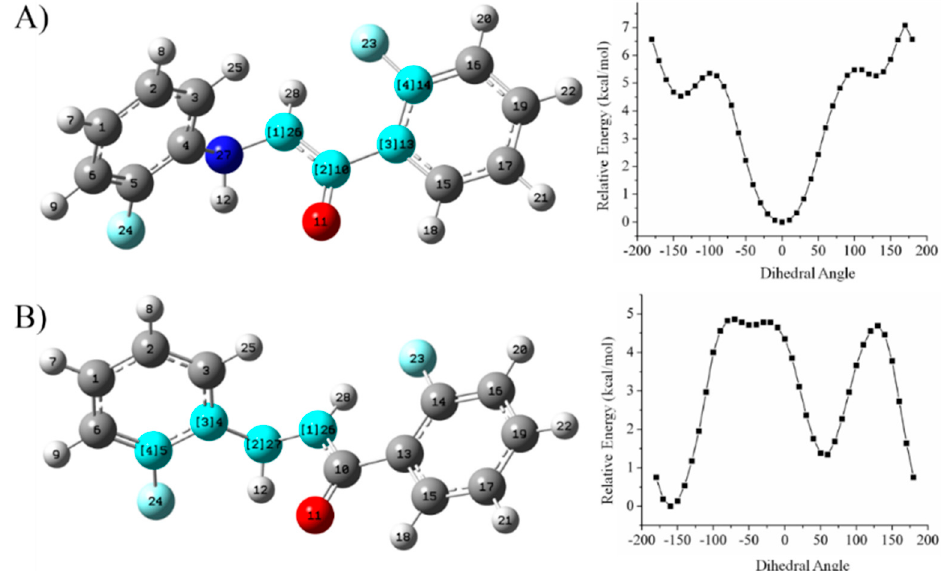
Figure 24. Relaxed potential energy surface scan for the internal rotation of phenyl ring through a single bond in molecule 20 . Selected dihedral angles; ( A ) N26–C10–C13–H14 ( B ) N26–N27–C4–C5.